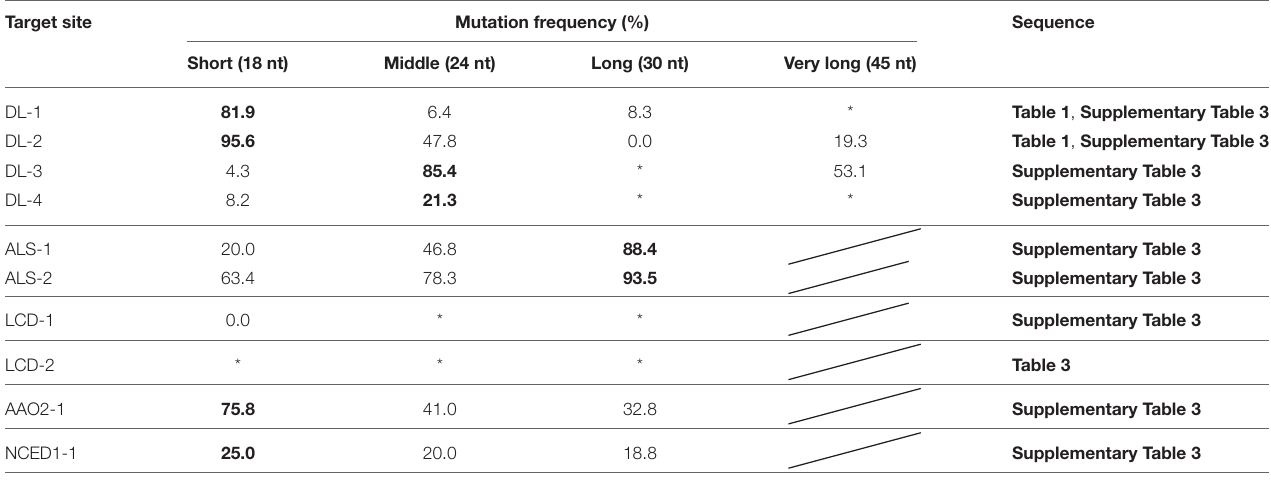
TABLE 2 | Mutation frequencies using crRNA with different lengths of guide sequences.